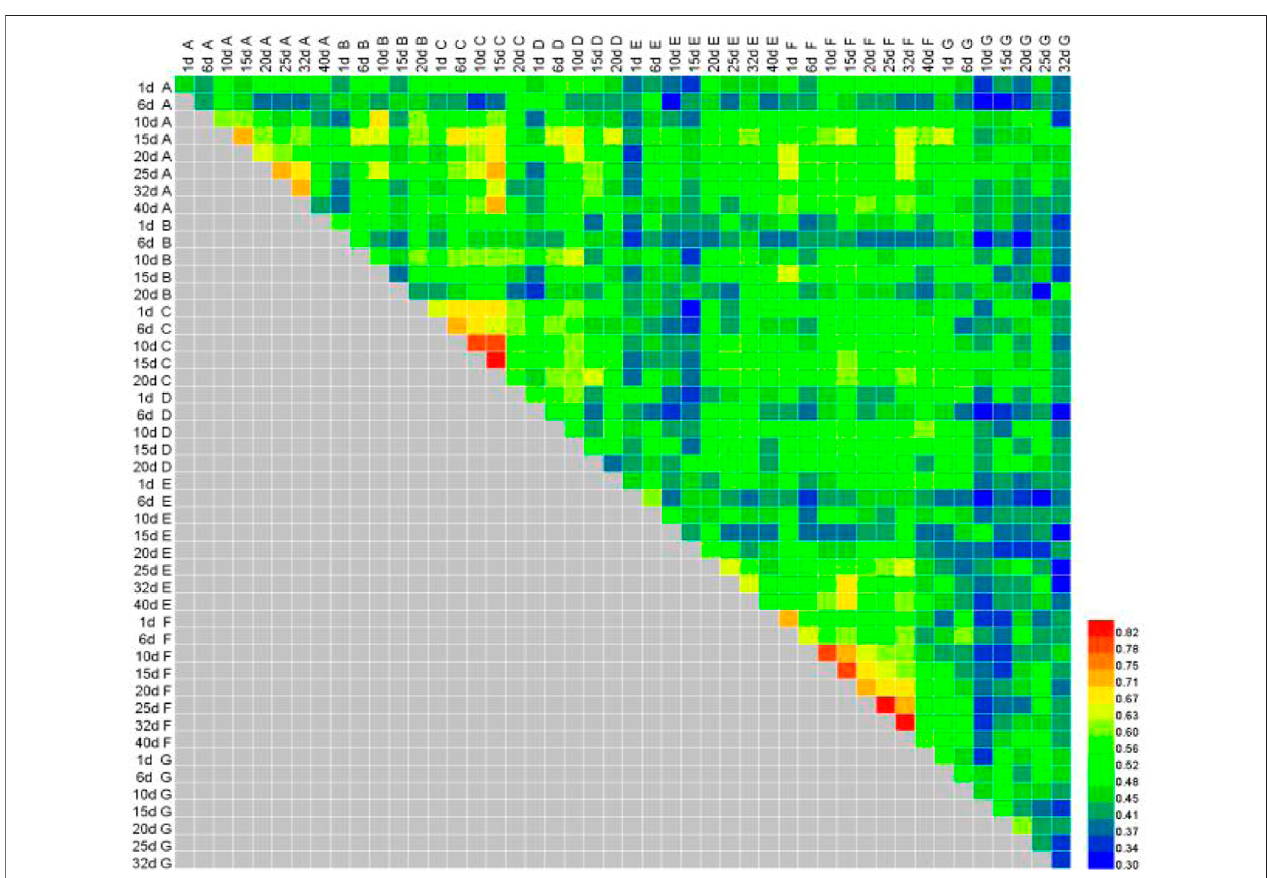
FIGURE 4 | Effects of sulfamethoxazole and enro fl oxacinon on habitat of culture ponds.